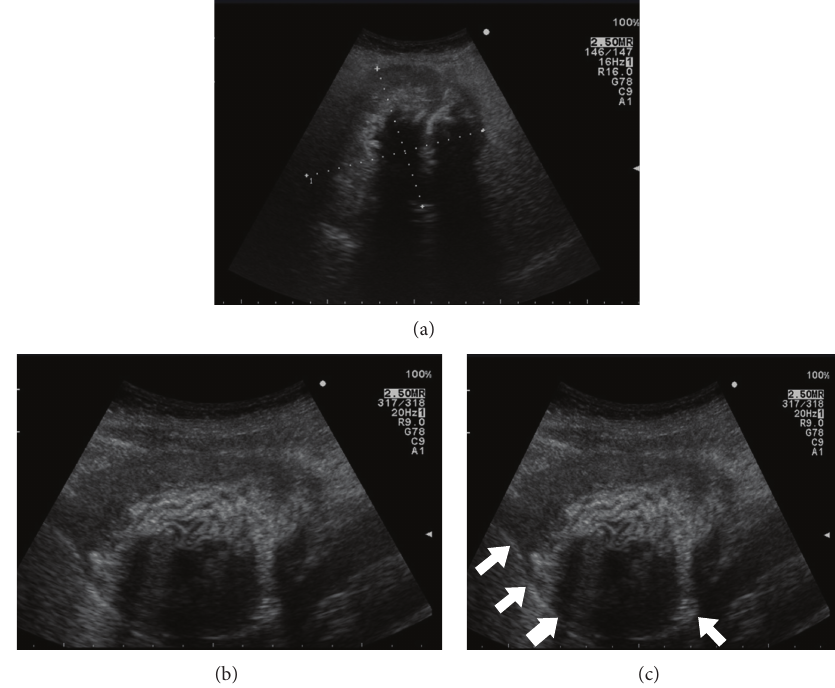
Figure 2: Extrahepatic gossypiboma seen at US scan. The arrows show the hepatic margin (c).